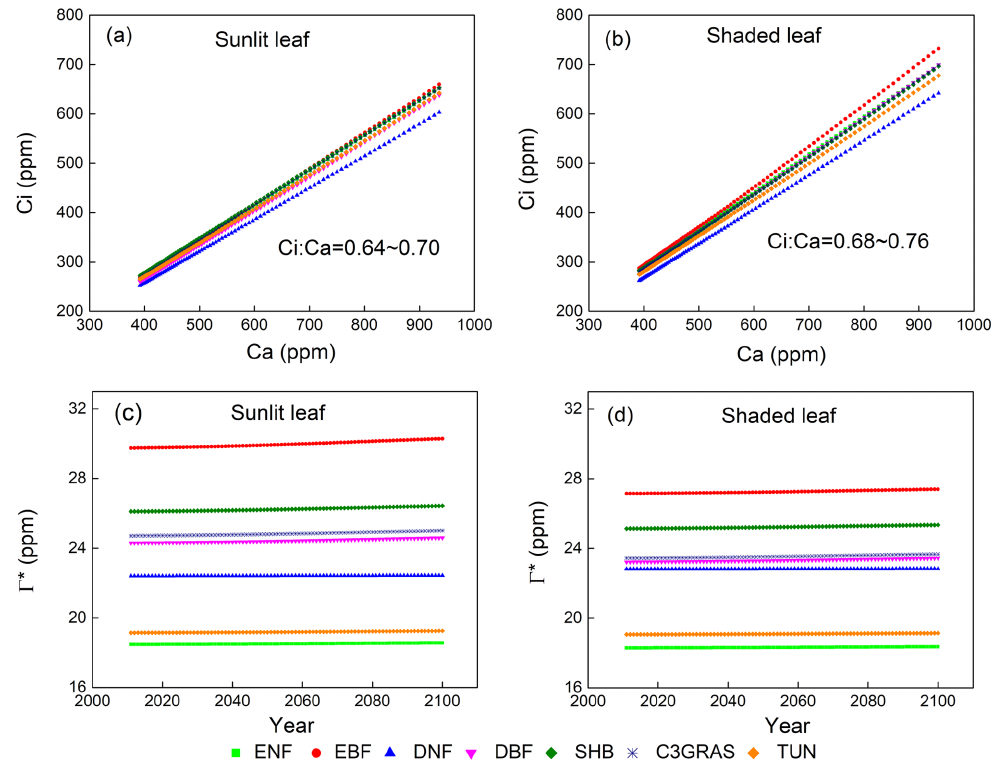
Figure 2. Responses of yearly intercellular CO 2 concentration ( C i ) to e CO 2 of a single sunlit leaf (a) and shaded leaf (b) for C 3 PFTs from CABLE-C-only simulation. Temporal trends of CO 2 compensation point in the absence of day respiration ( (cid:48) ∗ ) for sunlit leaf (c) and shaded leaf (d) from 2011 to 2100 from CABLE-C-only simulation. The ratio of C i to C a ( C i /C a ) is approximately constant with e CO 2 for each PFT and varies little across PFTs. (cid:48) ∗ values vary across different PFTs, but do not change over time for each PFT. Abbreviations and symbols are the same as Fig. 1. Table 2. Coefficients of variation of L , β p , β GPP , β NPP and β cpool across different geographical locations within each C 3 PFT at the year 2023 in the CABLE-C-only simulation. The two numbers in the same unit are for sunlit leaves and shaded leaves, respectively. Values for shaded leaves are in brackets. Abbreviations are the same as Fig. 1. PFT CV ( L ) CV ( β p ) CV ( β GPP ) CV ( β NPP ) CV ( β cpool ) sunlit (shaded) sunlit (shaded) ENF 0.27 (0.30) 0.41 (0.42) 1.77 EBF 0.26 (0.29) 0.24